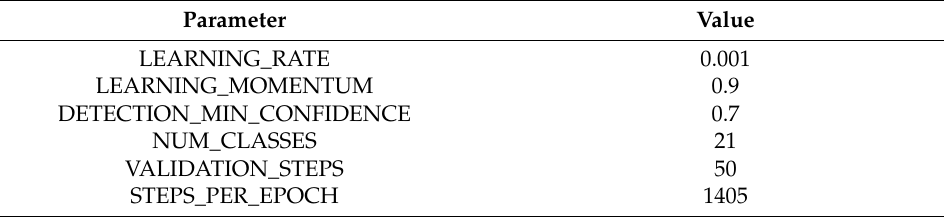
Table 1. Some of the designed object detection model’s parameters.